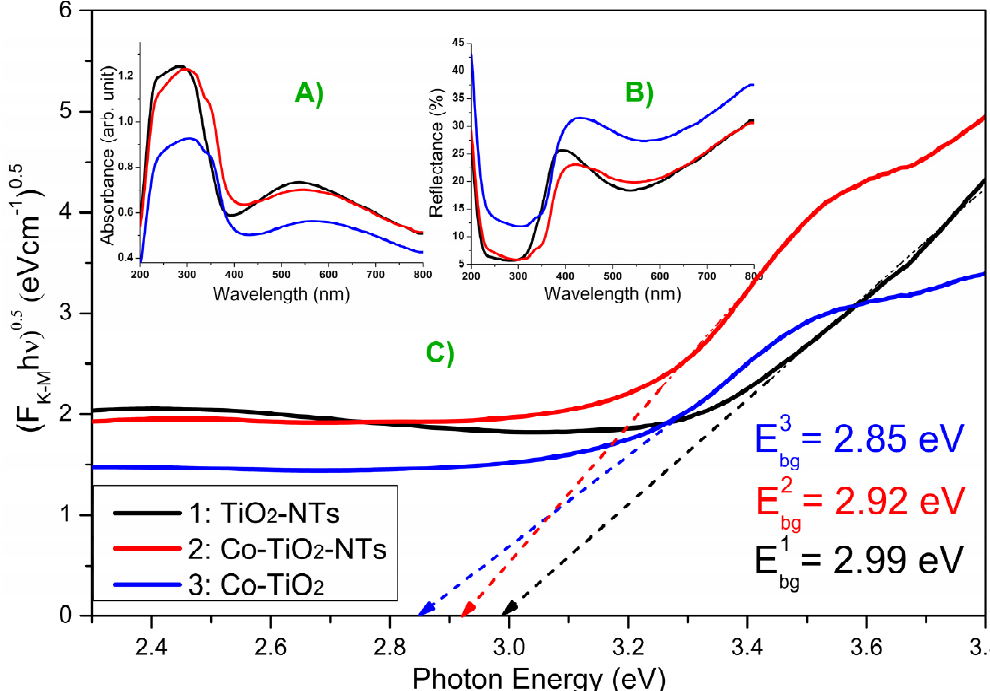
Figure 5. ( A ) Absorbance, ( B ) reflectance spectra, and ( C ) Tauc plot for samples TiO 2 -NTs, Co-TiO 2 -NTs, Co-TiO 2 .